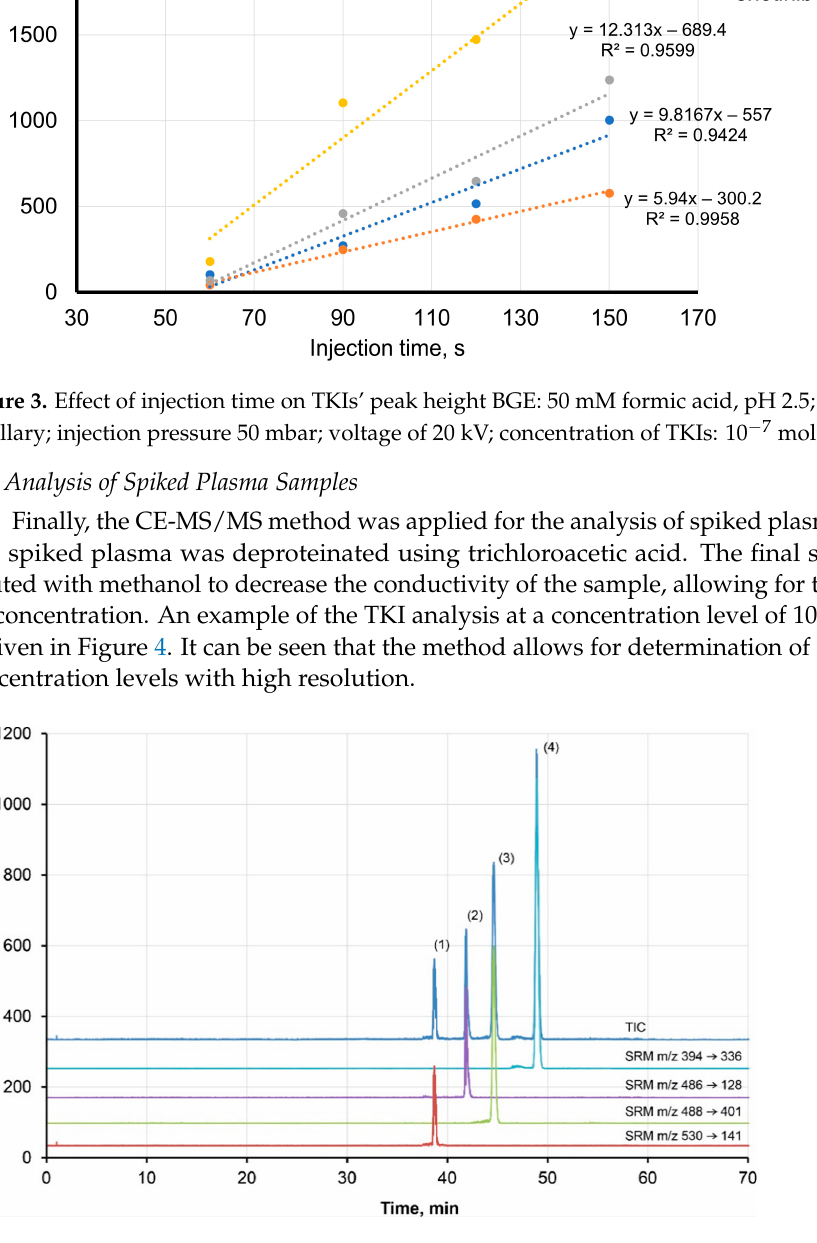
Figure 4. Example of analysis of the model TKIs by CE-MS/MS Peaks: (1) bosutinib, (2) canertinib, (3) dasatinib, (4) erlotinib; BGE: 50 mM formic acid, pH 2.5; 120 cm-long capillary; injection 120 s by 50 mbar; voltage of 20 kV; MS conditions: U ESI = 4.0 kV, T = 250 ◦ C, 5 µ L/min, 15 psi,